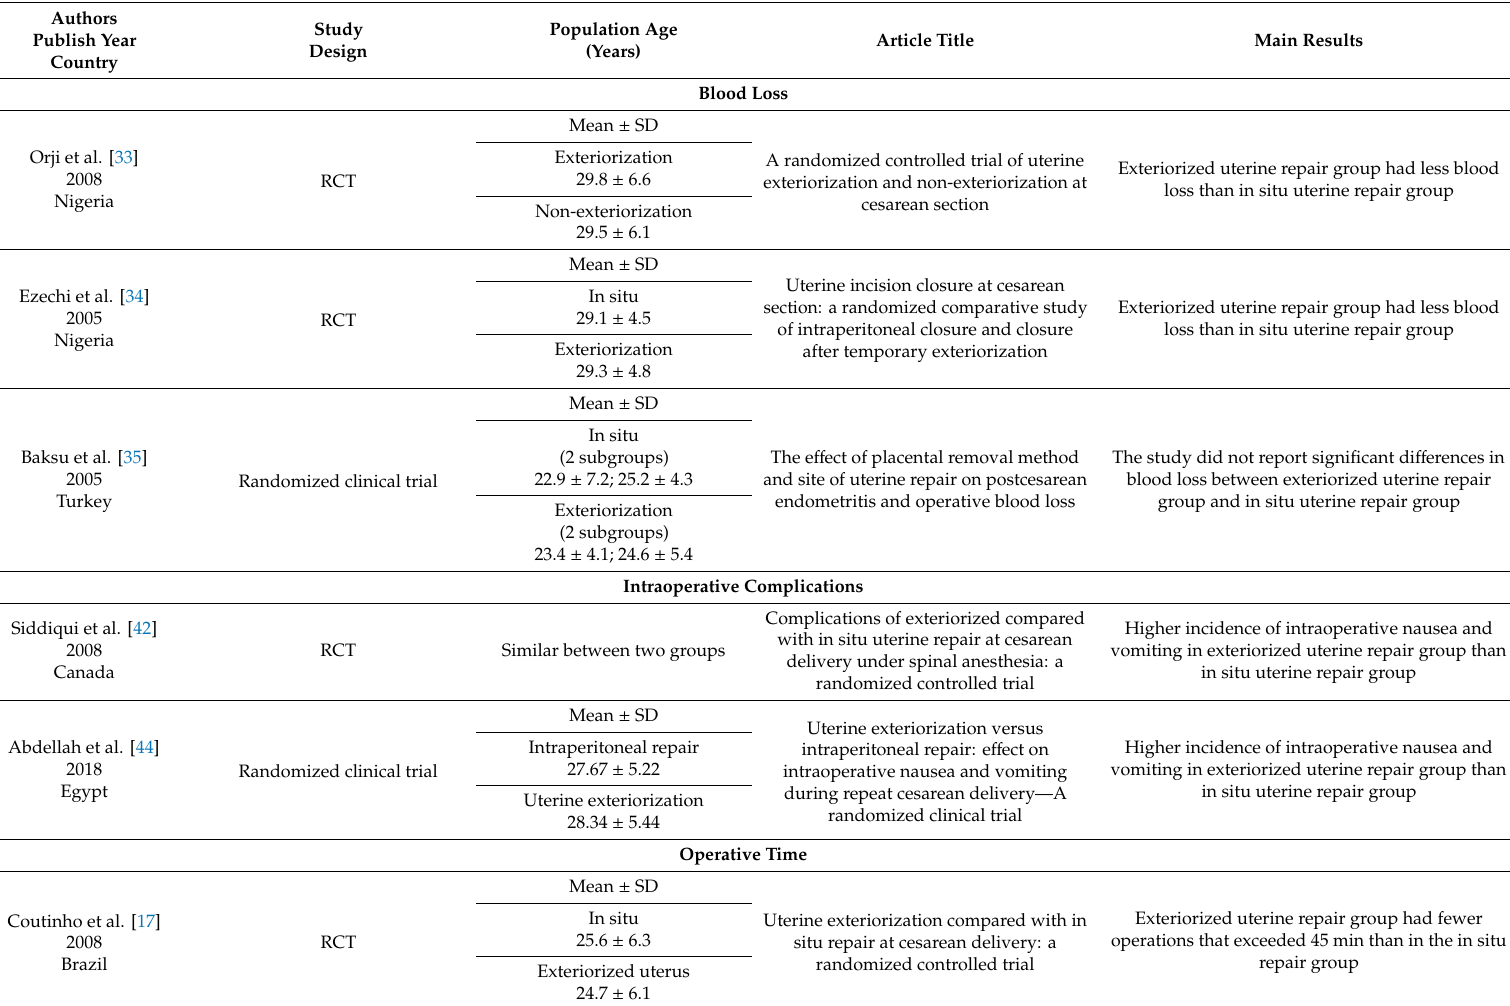
Table 1. Summary of current studies regarding comparison two di ff erent techniques of uterine repair during cesarean